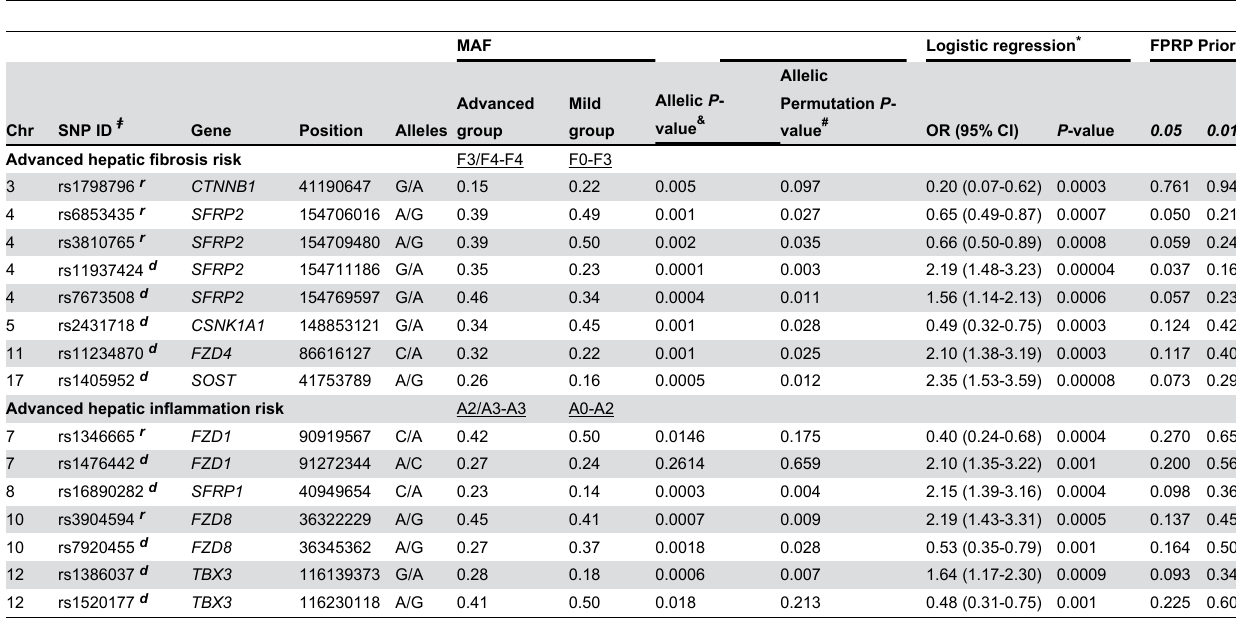
Table 2. Genotype frequencies of SNPs and the associations with advanced hepatic fibrosis or inflammation risk in patients with active HCV infection (P ≤